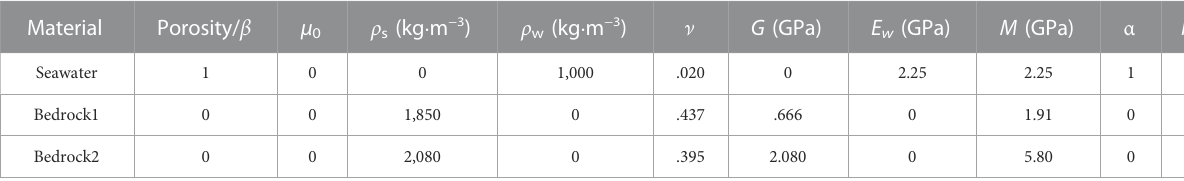
TABLE 1 Parameters of materials used in Tokyo Bay (Koketsu et al., 2009).